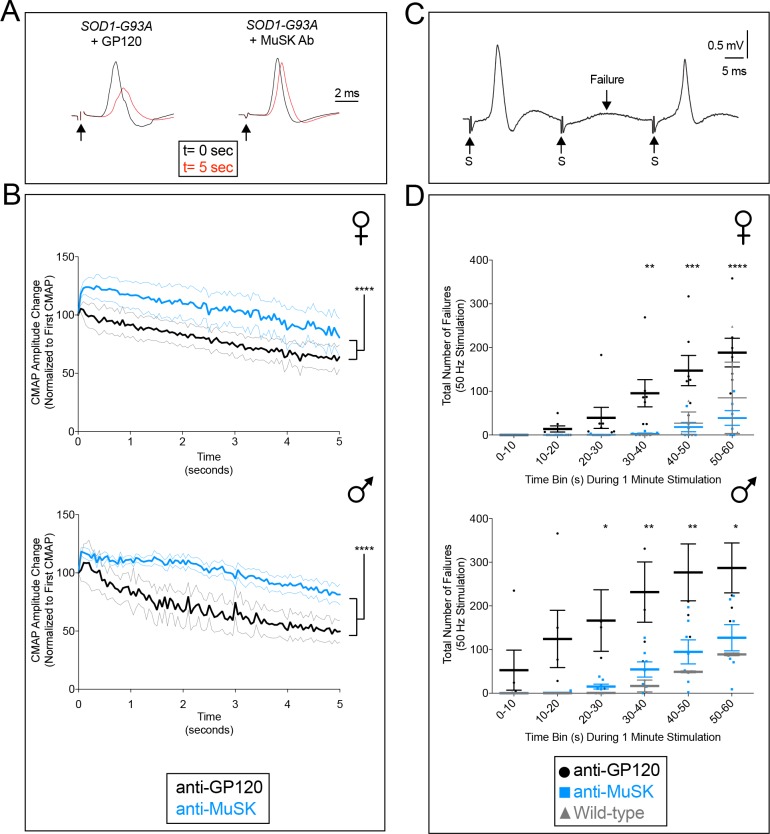
The MuSK agonist antibody improves motor system output in the diaphragm muscle.(A,B) 20 Hz stimulation (arrow) of the phrenic nerve from SOD1-G93A mice injected with the control antibody to GP120 led to a rapid and severe decline in the CMAP amplitude. In contrast, the CMAP amplitude decreased gradually and modestly in SOD1-G93A mice injected with the MuSK agonist antibody. After 5 s, the MuSK agonist improved CMAP amplitude by 13.6% in females and by 31.7% in males (n = 6–7; p<0.0001). The faint grey and blue lines indicate the SEMs. (C,D) 50 Hz stimulation (S, arrow) of the phrenic nerve in SOD1-G93A mice injected with the control antibody to GP120 led to frequent failures (F, arrow) to elicit a CMAP, whereas CMAPs were reliably elicited in SOD1-G93A mice injected with the MuSK agonist antibody, similar to the number of failures seen in wild type mice. The MuSK agonist antibody reduced the number of failures by 88% in females and 70% in males during 1 min of stimulation. The scatter plot shows the values for individual mice, as well as the mean values and SEM; *p<0.05, **p<0.01, ***p<0.001. The baseline CMAP amplitude data are as follows: anti-GP120-treated males, 5.95 ± 1.14 mV; MuSK agonist antibody-treated males, 5.93 ± 0.52 mV; anti-GP120-treated females, 4.95 ± 0.54 mV; MuSK agonist antibody-treated females, 5.81 ± 0.63 mV.